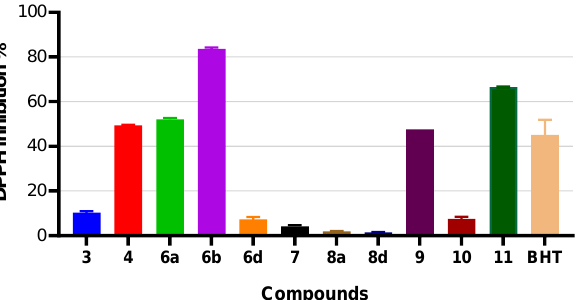
Figure 5. Antioxidant activity by DPPH assay of 3 – 11 compounds and synthetic antioxidant BHT. Data are shown as mean ± SD from three experimental replicates.